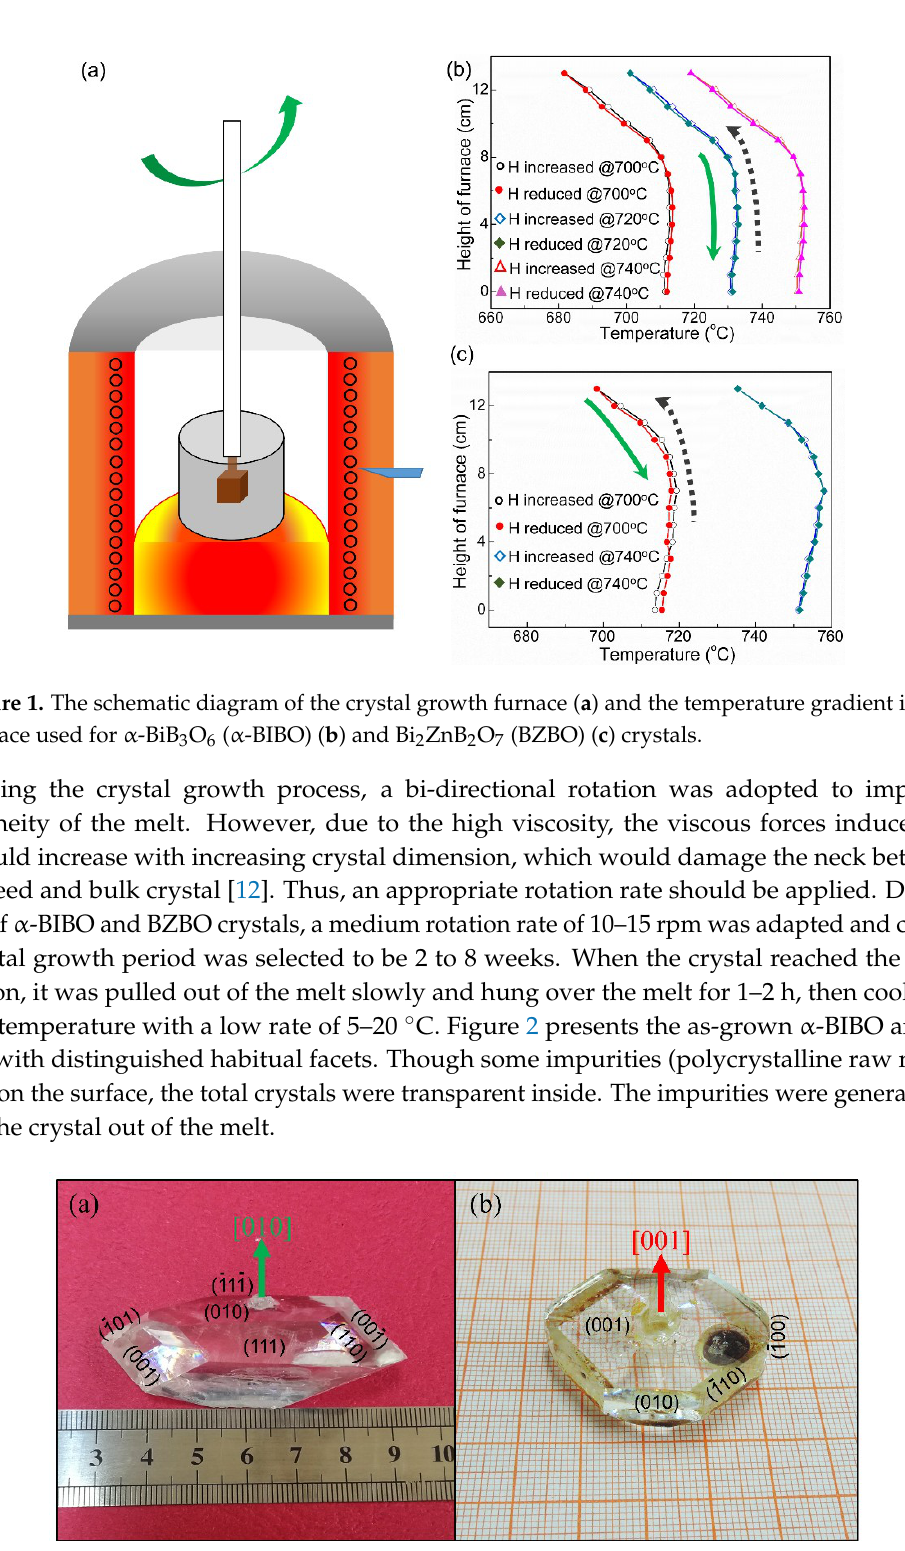
α -BIBO ( a ) and BZBO ( b ) single Figure 2. The as-grown α-BIBO ( a ) and BZBO ( b ) single crystals. Figure 2. The as-grown α-BIBO ( a ) and BZBO ( b ) single crystals. Figure 2. The as-grown